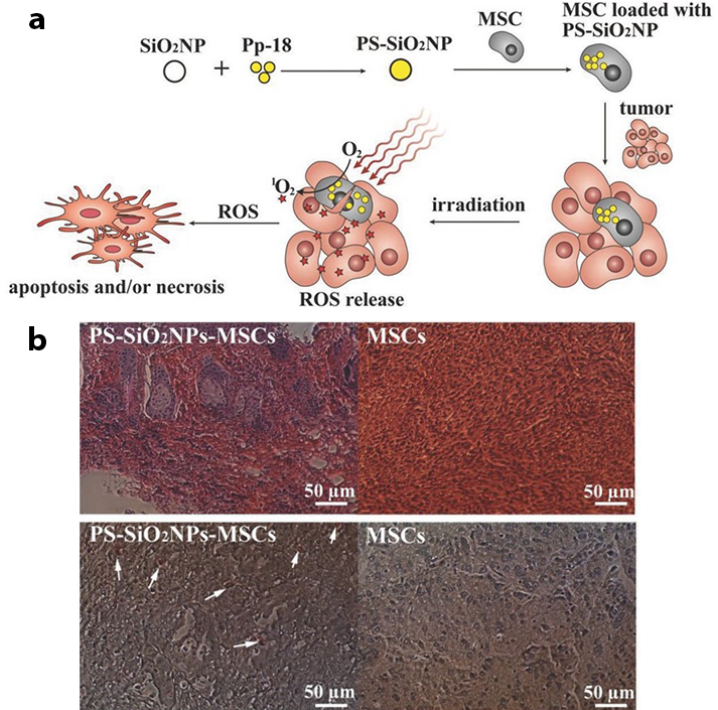
Figure 7. ( a ) PDT treatment of cancer cell using PS-loaded SiO2NPs into MSCs, ( b ) In vivo PDT treatment on tumors one day after co-injection of MCF-7 cancer cells and MSCs with (group 1: PS-SiO2NPs-MSCs group) or without (group 2: control MSCs group) PS-SiO2NPs loaded. Reprinted with permission from reference [114] . Copyright 2014 Willey Online Library.